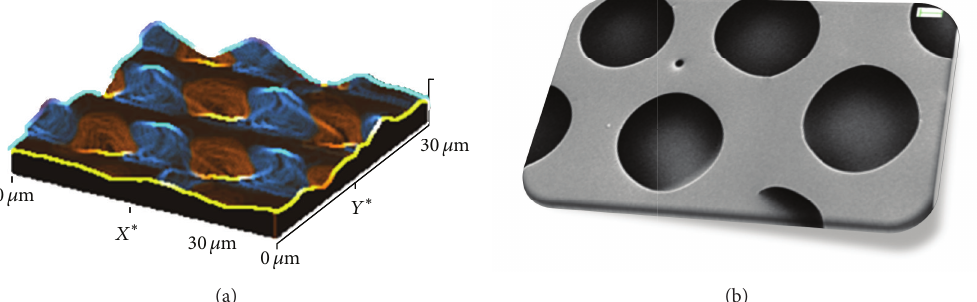
Figure 5: Atomic force microscopy (AFM) (a) and field emission scanning electron microscopy (FESEM) (b) images of PLGA/3Ag nano- composite